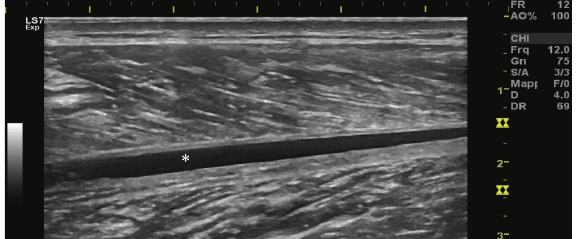
Figure 3: Interfascial blood ( asterisk ), observed at the distal region of the